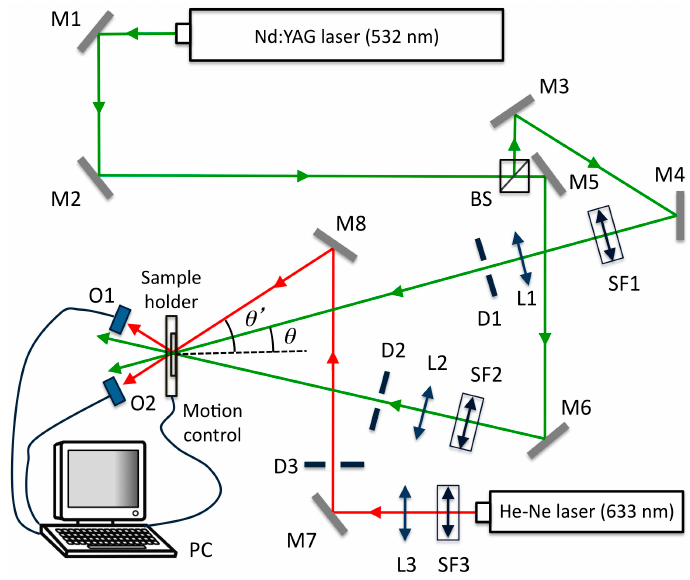
Figure 2. Holographic set-up. BS: Beamsplitter; Mi: Mirror; SFi: Spatial filter; Li: Lens; Di: Diaphragm; Oi: Optical power meter; PC: Data recorder.